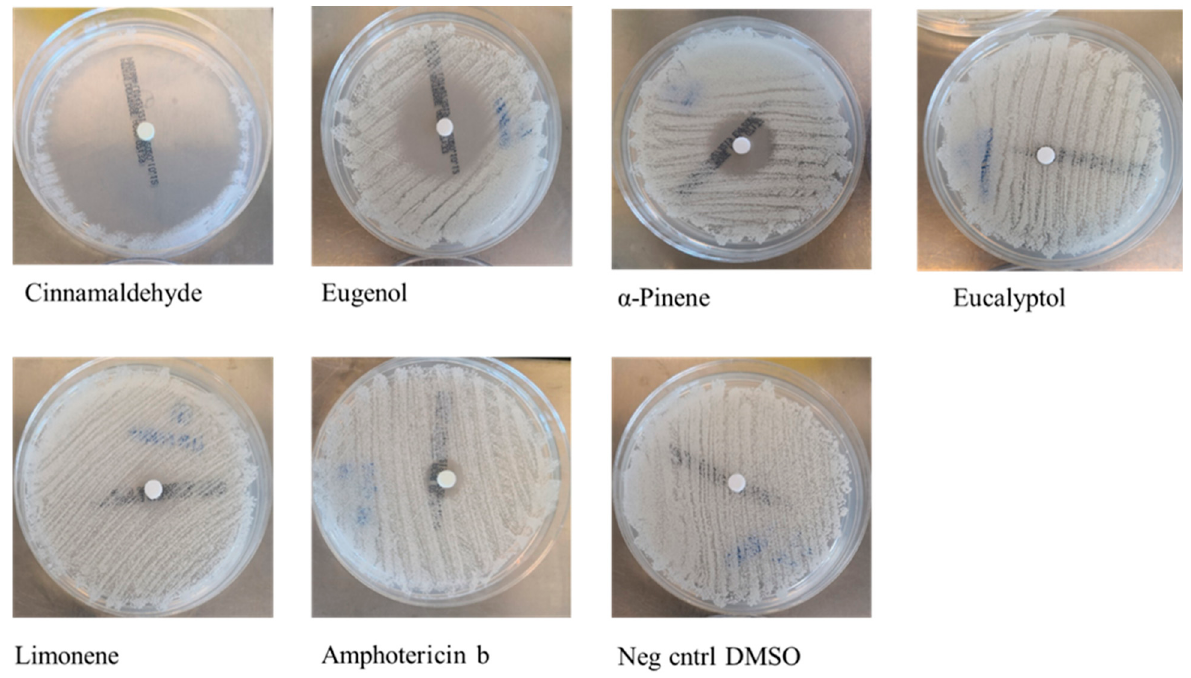
Figure 1. Representative pictures of agar diffusion assay. Table 3. Summary of the results from microdilution assay.